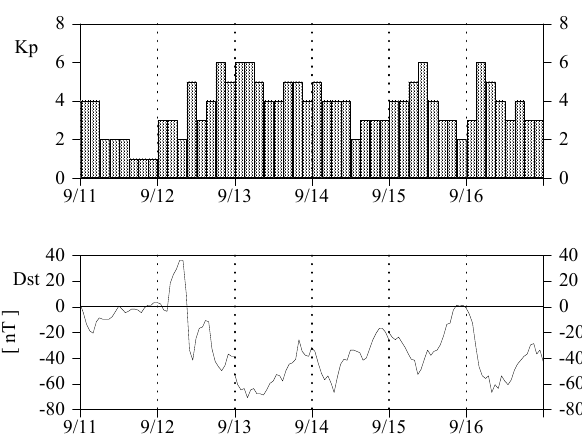
Fig. 1. Kp and Dst variations during 11–16 September 1999.